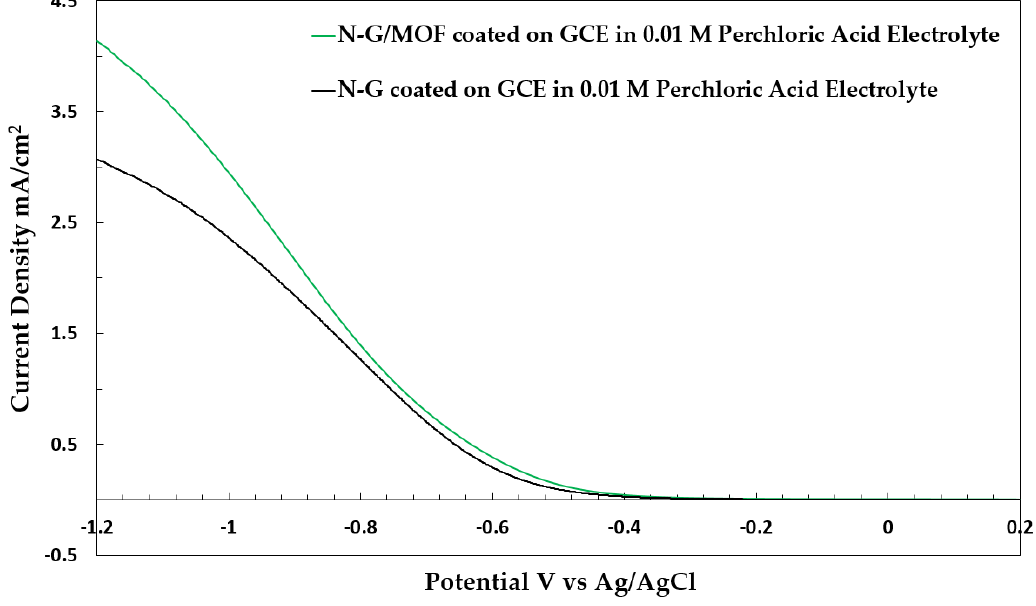
Figure 3. LSV plot for ORR in the oxygen saturated 0.01 HClO 4 electrolyte on the N-G/MOF (green line) and N-G (black line) catalysts coated GC working electrode.